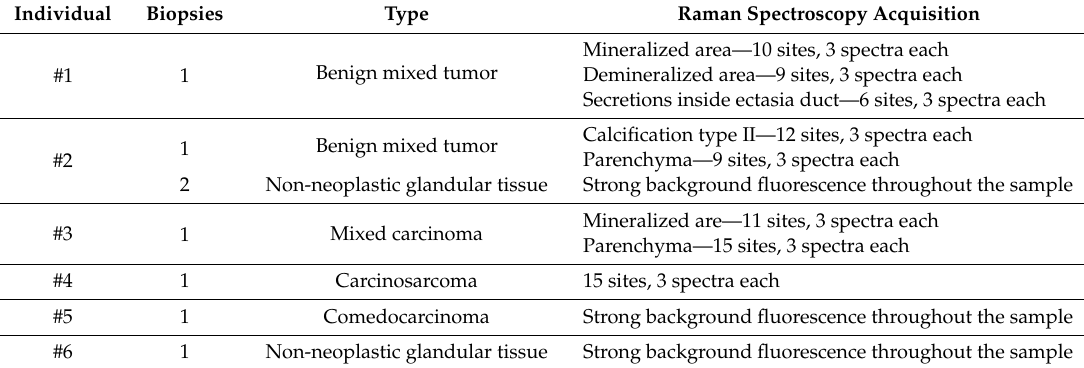
Table 2. Number of sites and number of spectra per site obtained in each